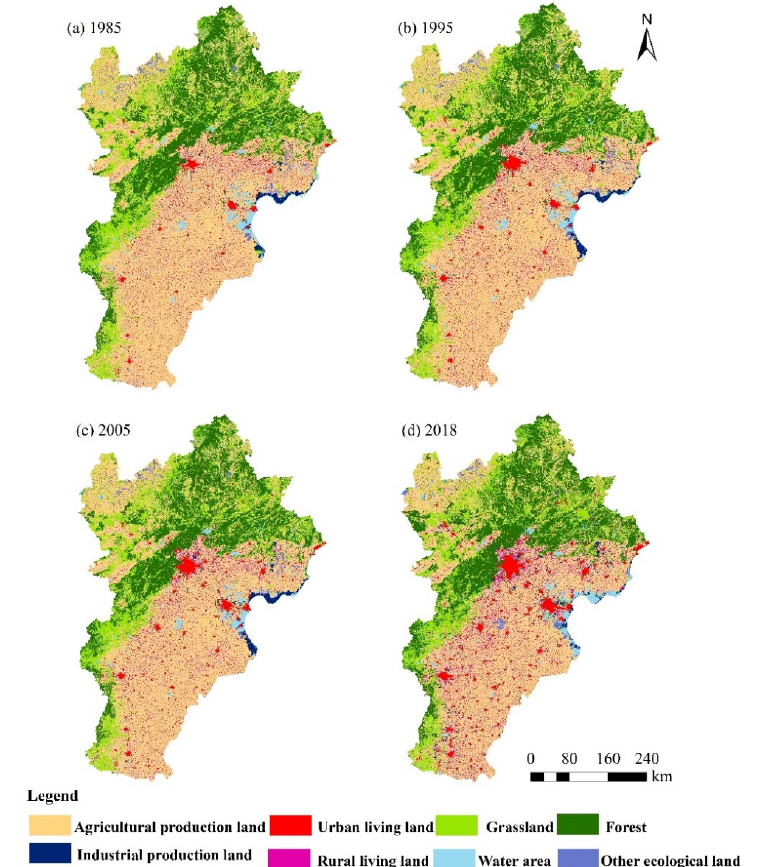
Figure 3. The production–living–ecological land use maps for the years ( a ) 1985; ( b ) 1995; ( c ) 2005; ( d ) 2018.